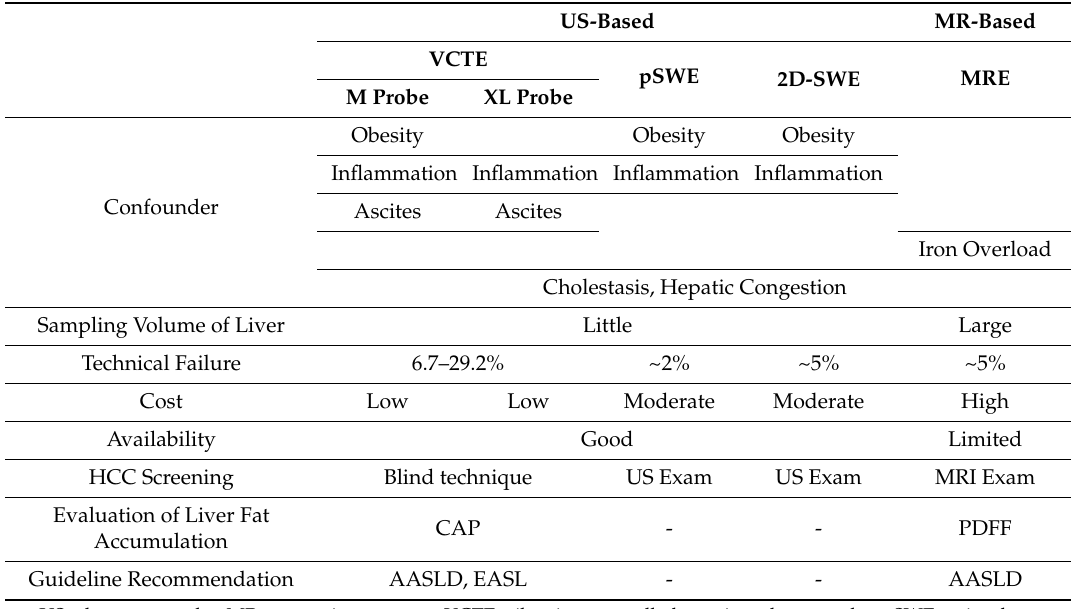
Table 2. Advantages and limitations of elastography